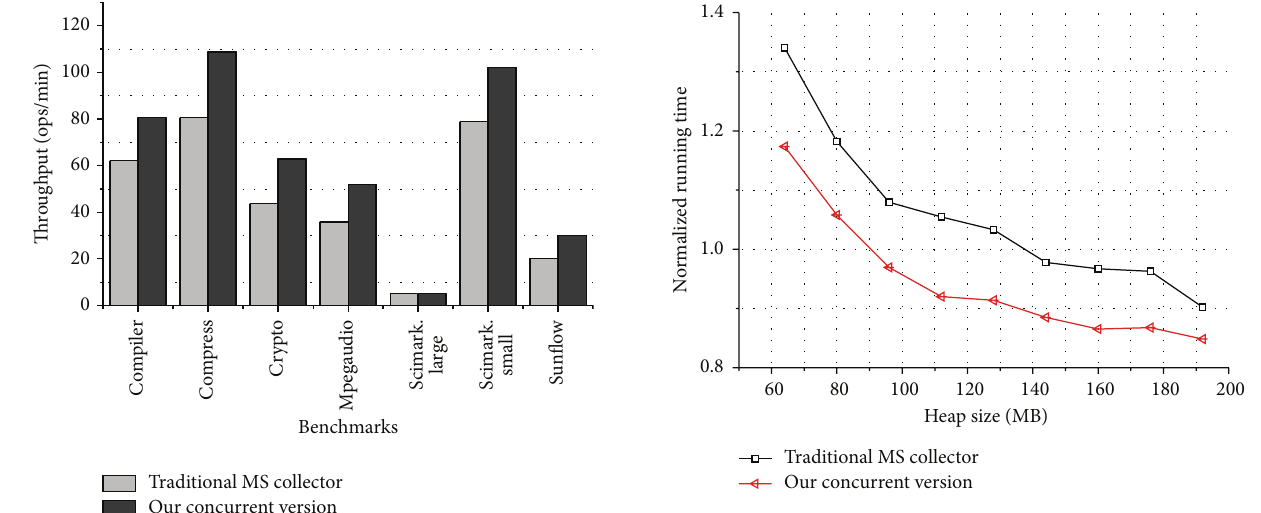
Figure 7: Normalized execution times for Dacapo benchmarks, with variable sized heap. Lower running time means better perfor- mance of the